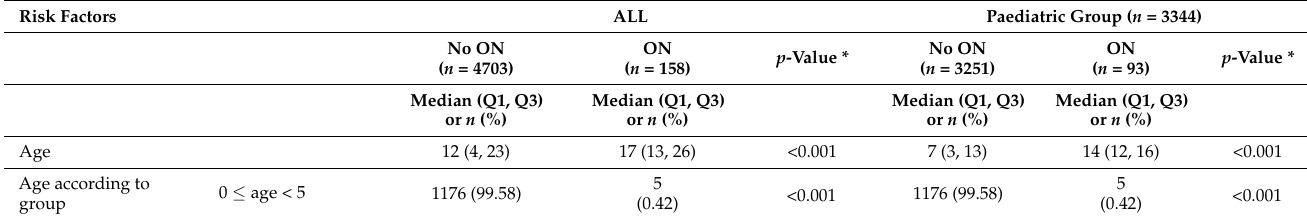
Table 2. Risk factors of osteonecrosis.